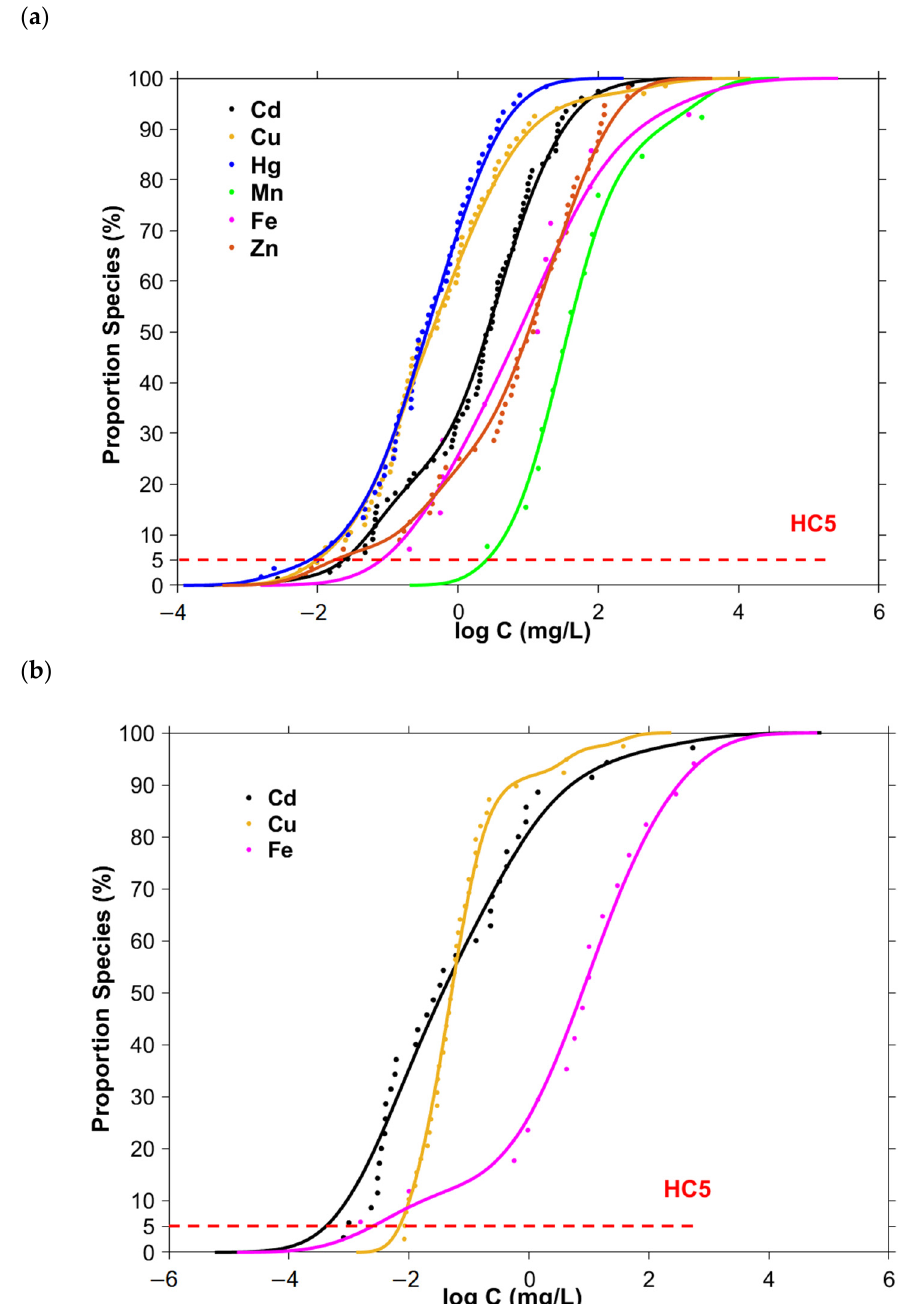
Figure 1. NPKDE-SSDs for typical transition metals in South Asia. ( a ) Acute NPKDE-SSDs for six typical transition metals (Cd ( ● ), Cu ( ● ), Hg ( ● ), Mn ( ● ), Fe ( ● ), and Zn ( ● )) in South Asia. ( b ) Chronic NPKDE-SSDs for three typical transition metals (Cd ( ● ), Cu ( ● ), and Fe ( ● )) in South Asia.